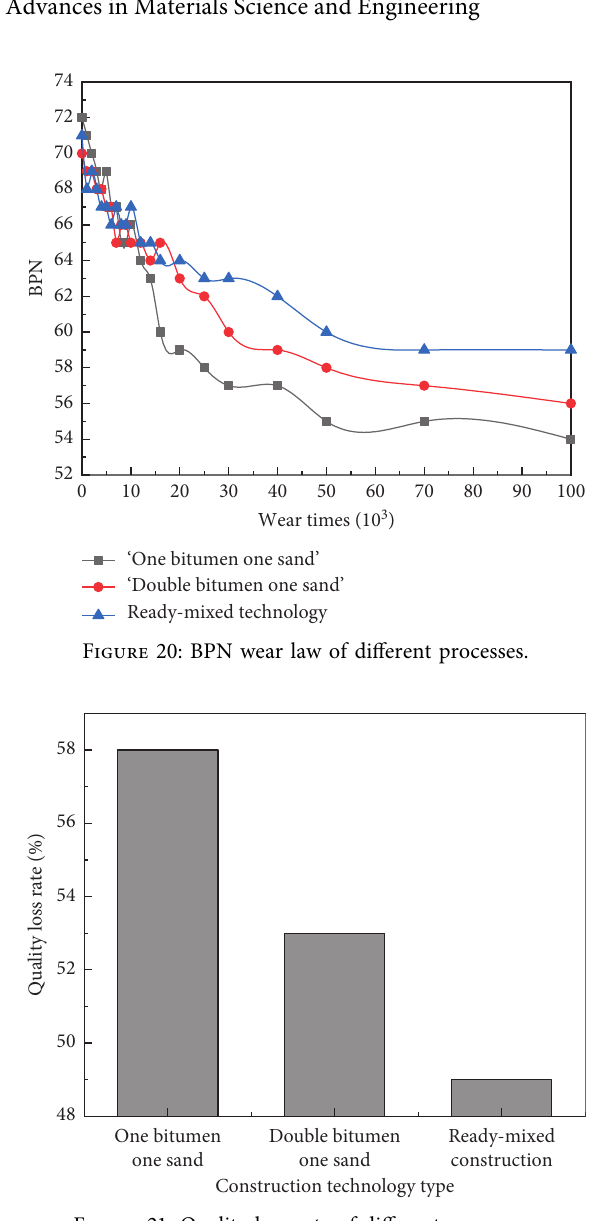
Figure 21: Quality loss rate of different